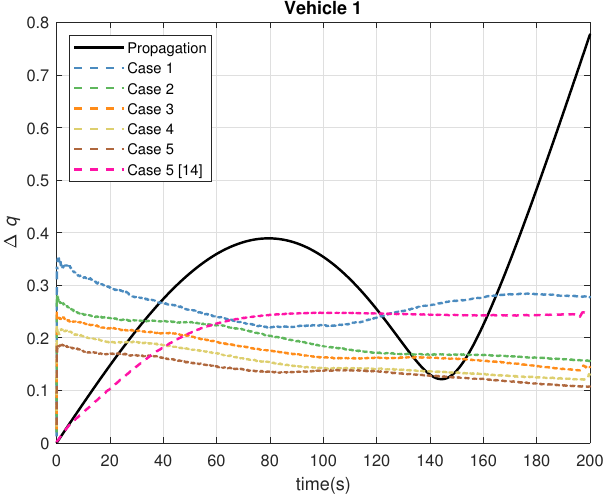
Figure 8. Scenario 1—vehicle 1 mean ∆ q